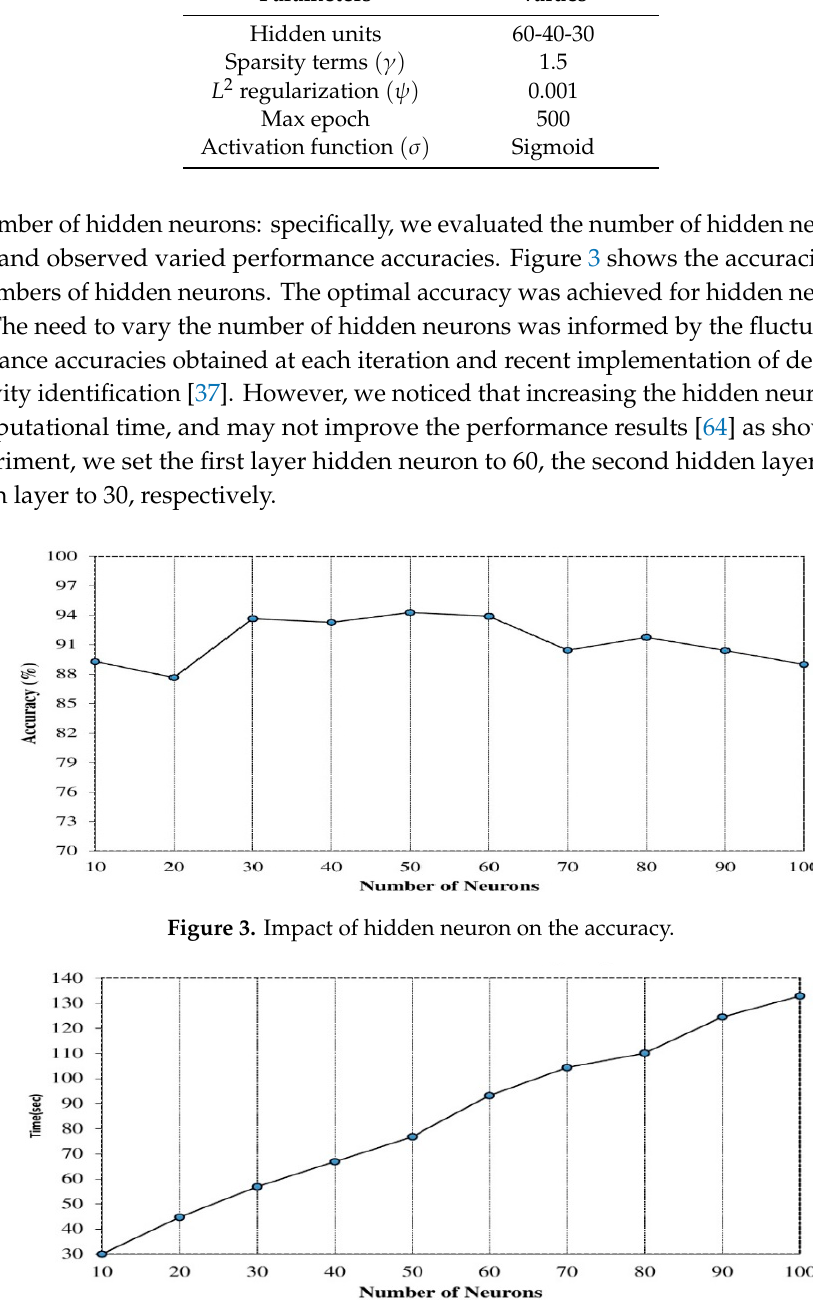
Table 3. Experimental Parameter Setting. Table 4. Experimental Parameter Setting. Table 4. Experimental Parameter Setting.